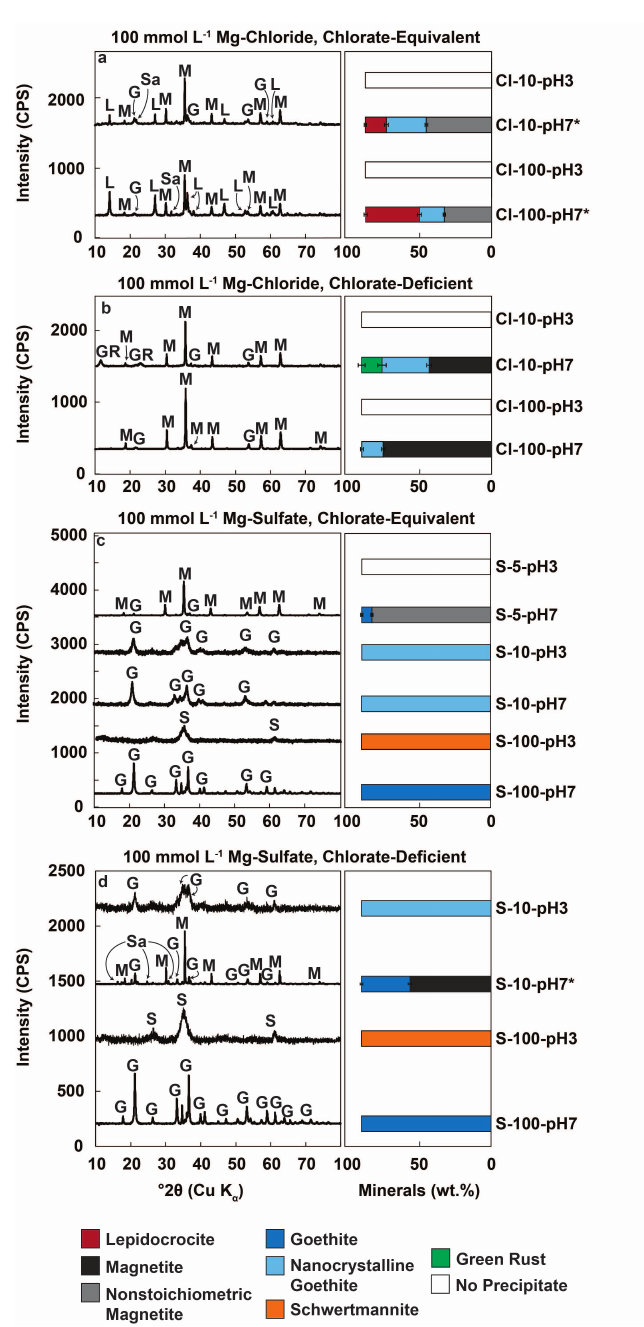
Figure 2. XRD patterns of the mineral products (left) and phase proportions generated using Rietveld refinement (right) for the corresponding XRD scans (Figures S3–S6) of the precipitates formed by the oxidation of dissolved Fe(II) by chlorate (ClO 3 − ). Chloride-rich fluids using ( a ) [Fe(II)] / [ClO 3 − ] ≈ 6 and ( b ) [Fe(II)] / [ClO 3 − ] ≈ 10 and sulfate-rich fluids using ( c ) [Fe(II)] / [ClO 3 − ] ≈ 6 and ( d ) [Fe(II)] / [ClO 3 − ] ≈ 10 were investigated. Thesamplelabelsdepictfluidtype, initialFe(II)concentration(mmolL − 1 ), MgCl 2 concentration (mmol L − 1 ), and initial pH (sample label details in Table 2, except segregated by initial Fe(II) to chlorate ratio). The abbreviated names of each experiment represent the fluid composition (either Cl = chloride, or S = sulfate), concentration of Fe(II) in mmol L − 1 , and the initial pH. Diagnostic peaks are as follows: G = Goethite, L = Lepidocrocite, M = Magnetite, GR = Green Rust, S = Schwertmannite, and Sa = Salt (bischofite [MgCl 2 · 6H 2 O], halite [NaCl], or hexahydrite [MgSO 4 · 6H 2 O]). The scans are offset from each other and scaled for better visualization; CPS = counts per